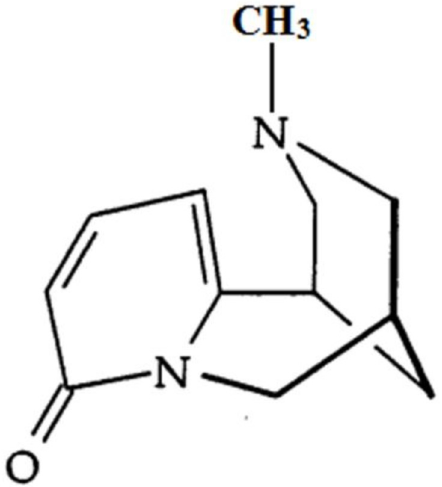
Figure 1. The chemical structure of N - methylcytisine (NMC).